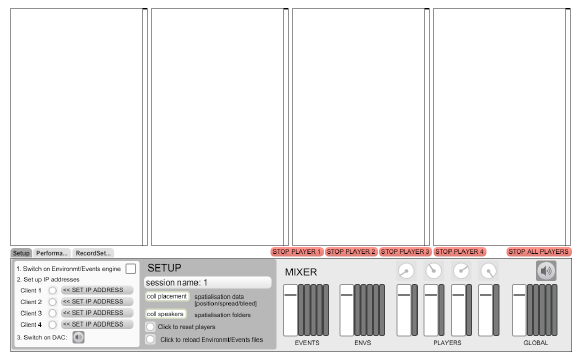
1 | Fig. 1. – Serve patch with features of the setup.